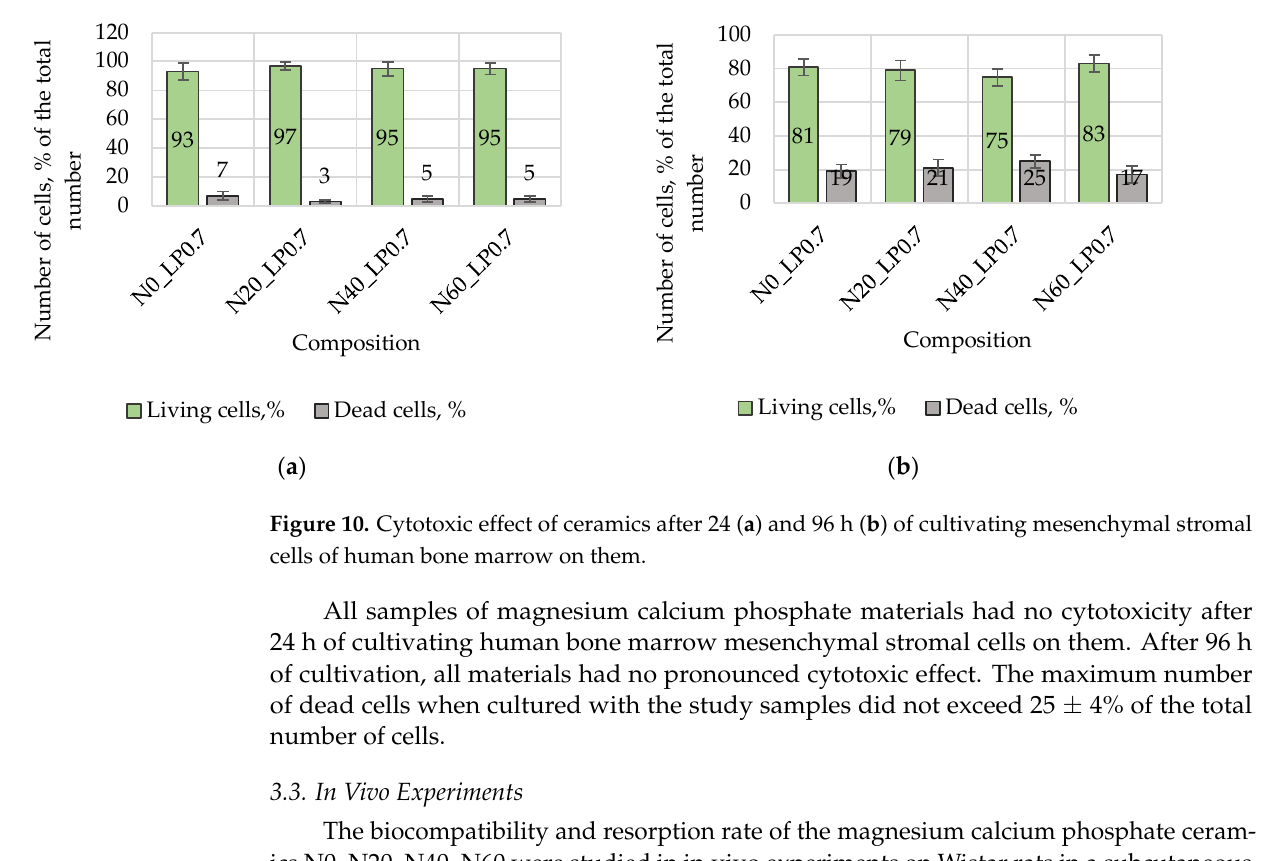
16 (b) Figure 9. Quantitative phase composition of ceramics: ( a ) N0 when setting retarders are introduced, ( b ) magnesium containing SPP and CA after incubation of physiological solution. Significant differences are labeled with * ( p < 0.05).